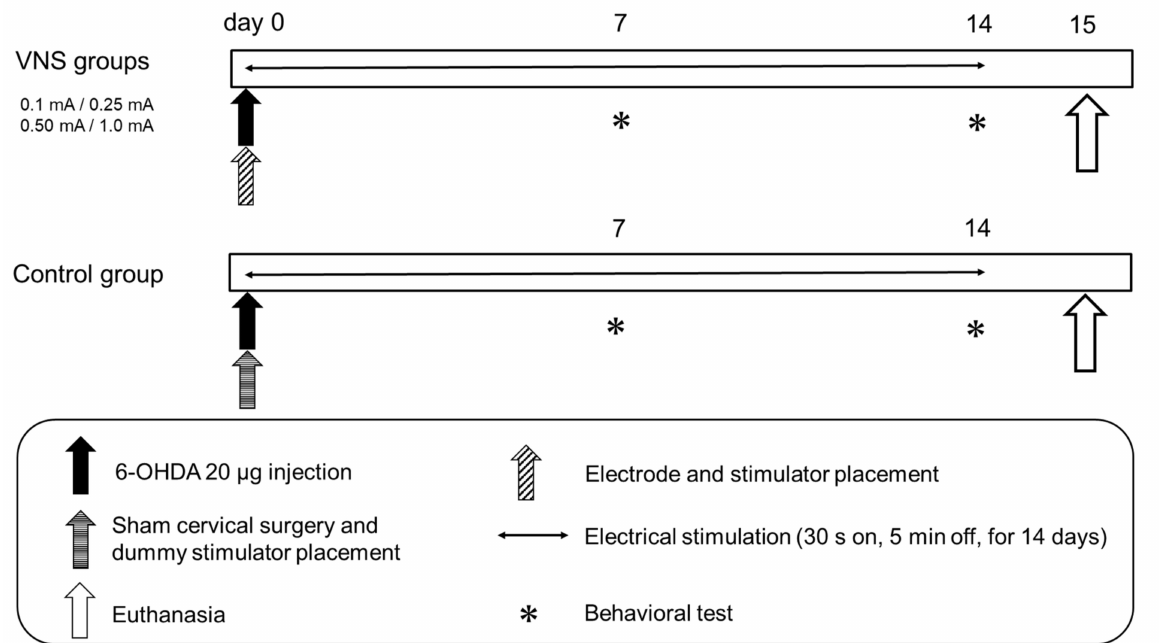
Figure 3. Experimental protocol. Fifty rats were randomly divided into five groups ( n = 10 in each). On day 0, the left vagus nerve was exposed, and the cuff type silver electrode was placed. The electrode lead was connected to the SAS-200 and fixed to the back of the rats. Thereafter, 20 µ g of 6-hydroxydopamine (6-OHDA) was stereotactically administered into the left striatum to prepare a Parkinson’s disease (PD) model. Vagus nerve stimulation (VNS) was started immediately after 6-OHDA administration and was continued for 14 days. On days 7 and 14, behavioral evaluation was performed with cylinder test and methamphetamine-induced rotation test. All rats were then euthanized on day